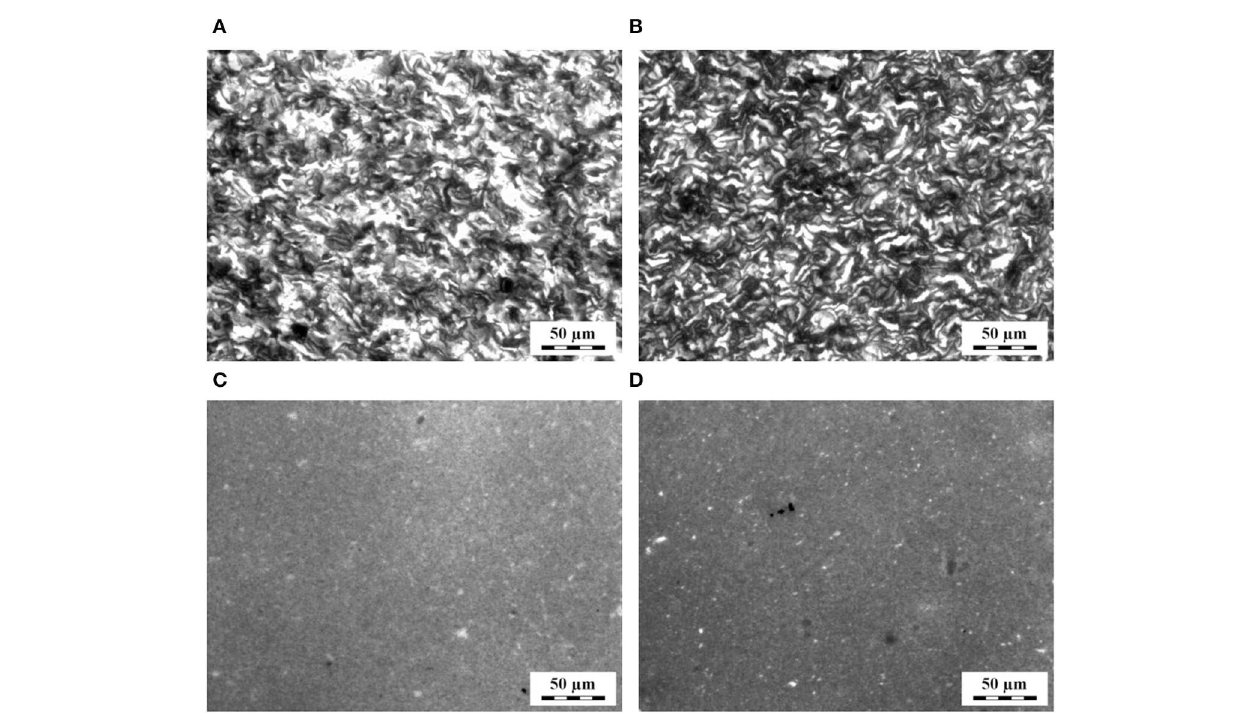
FIGURE 1 | LM micrographs showing the structure of the TPS/TiO 2 composites with (A,C) 10% and (B,D) 20% of the filler: (A,B) after solution casting and (C,D) after solution casting and melt mixing.